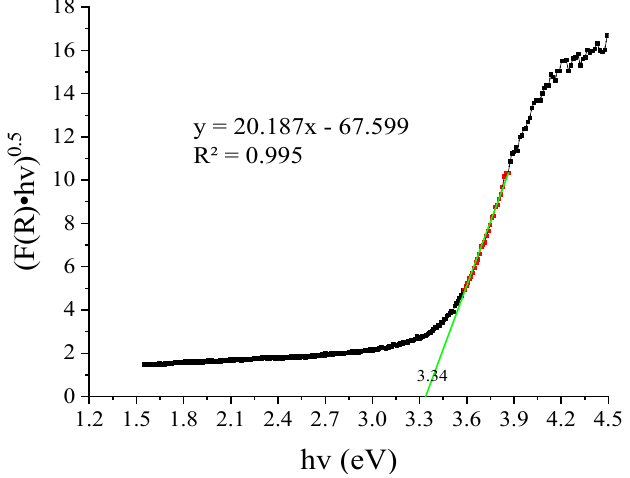
Figure 13. Estimation of bandgap energy (E g ) of the catalyst SL400 using the Kubelka-Munk function, the red points represent those used to obtain the slope of the line and obtain the intercept on the x axis.